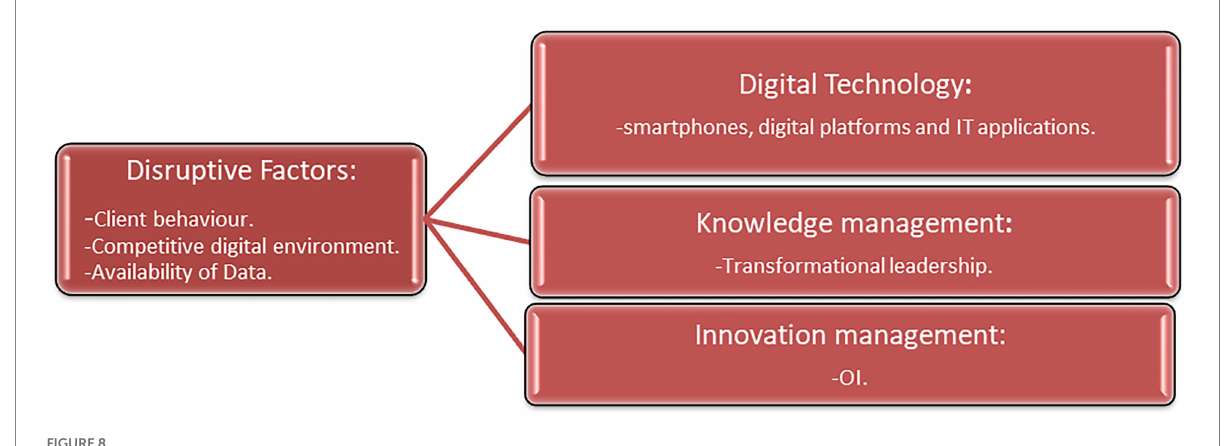
FIGURE 8 Factors needed for successful DT. Source: Authors